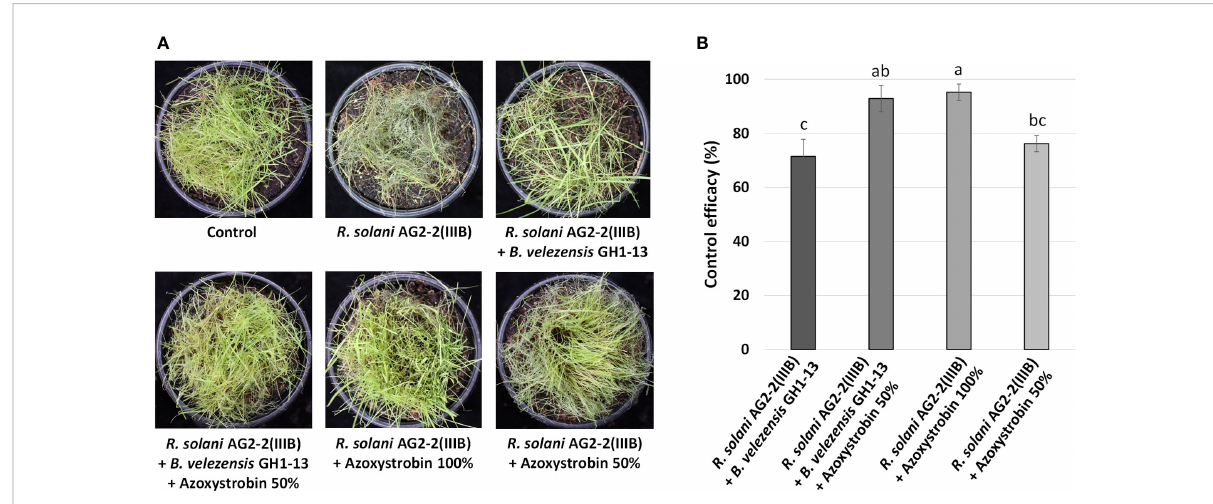
FIGURE 4 Effects of Bacillus velezensis GH1-13 and azoxystrobin on control of brown patch of creeping bentgrass in pot assay. (A) The symptoms of brown patch caused by Rhizoctonia solani AG2-2(IIIB) on creeping bentgrass and brown patch control by application of B. velezensis GH1-13 (1×10 6 cfu/ml), 50% azoxystrobin (10 m g ml -1 ), 100% azoxystrobin (20 m g ml -1 ), or the mixture of B. velezensis GH1-13 (1×10 6 cfu/ml) and 50% azoxystrobin (10 m g ml -1 ). (B) Control ef fi cacy of different applications against brown patch. The bars followed by the same letter are not signi fi cantly different at P< 0.05 in Tukey ’ s HSD